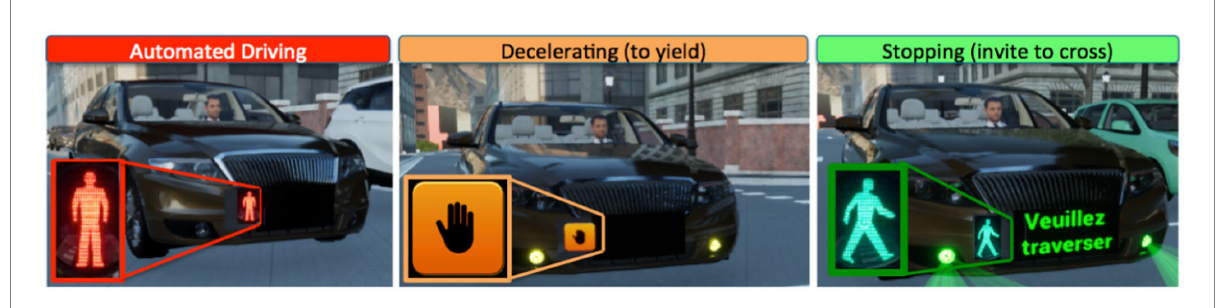
FIGURE 4 Pictograms of the external human–machine interface (HMI) used to inform pedestrians about the AV